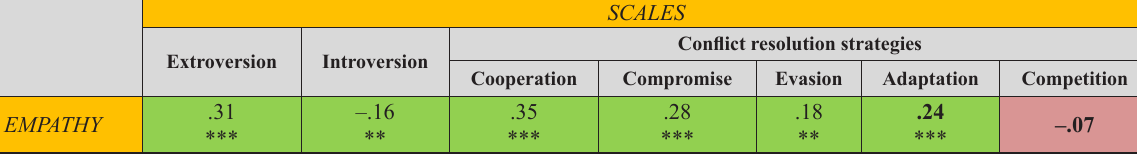
Table 2. Correlation (Spearman’s Correlation Coefficient) between empathy and interpersonal relationship effectiveness scales